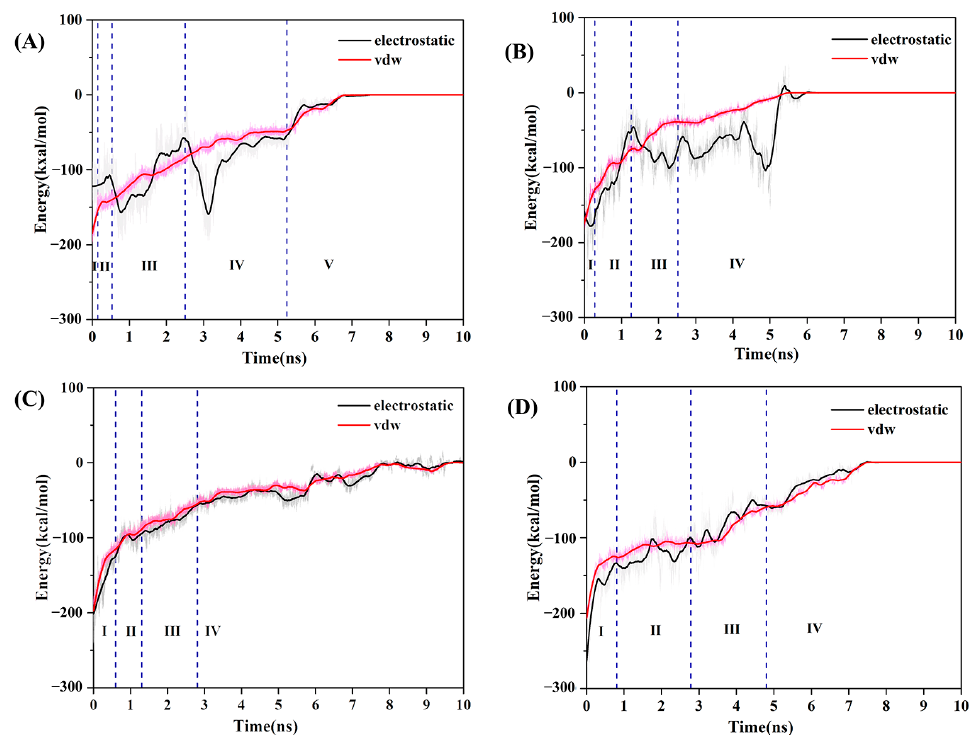
Figure 6. Changes of the energy between the boundary chain and template for ( A ) human brain system; ( B ) cofactor-tau system; ( C ) cofactor-free system in path 1; and ( D ) cofactor-free system in path 2. I–V represent the dissociation stages. The black lines represent electrostatic interactions, red lines represent van der Waals interactions, and blue dashed lines distinguish different stages.